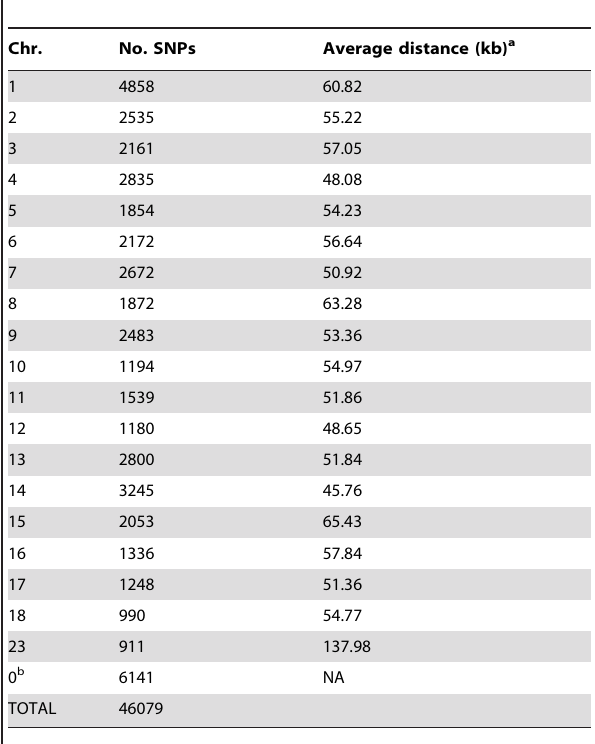
Table 2. Distribution of SNPs after quality control on each